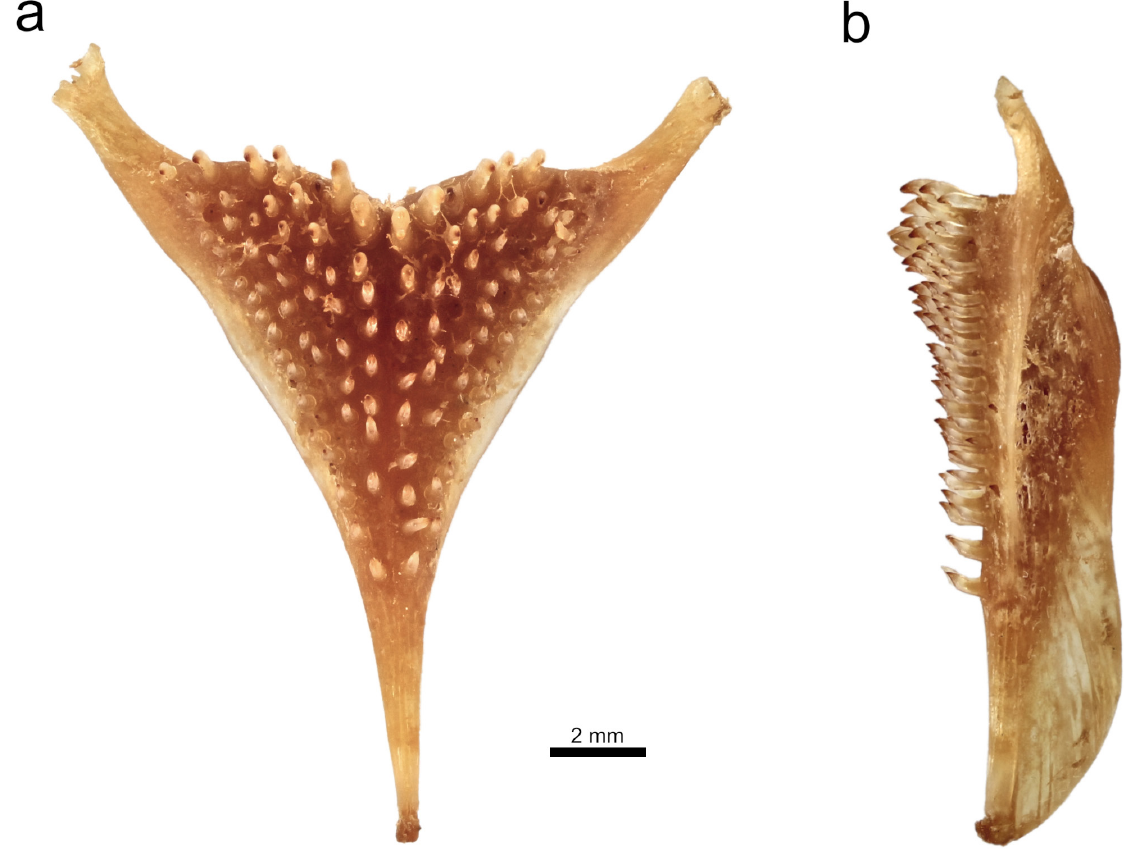
Fig. 7. Haplochromis latifrons sp. nov. (RMCA 2018.008.P.0329; 155.7 mm SL). a . Dorsal view of the lower pharyngeal jaw. b . Lateral view of the lower pharyngeal